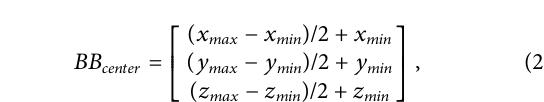
Frontiers in Bioengineering and Biotechnology |